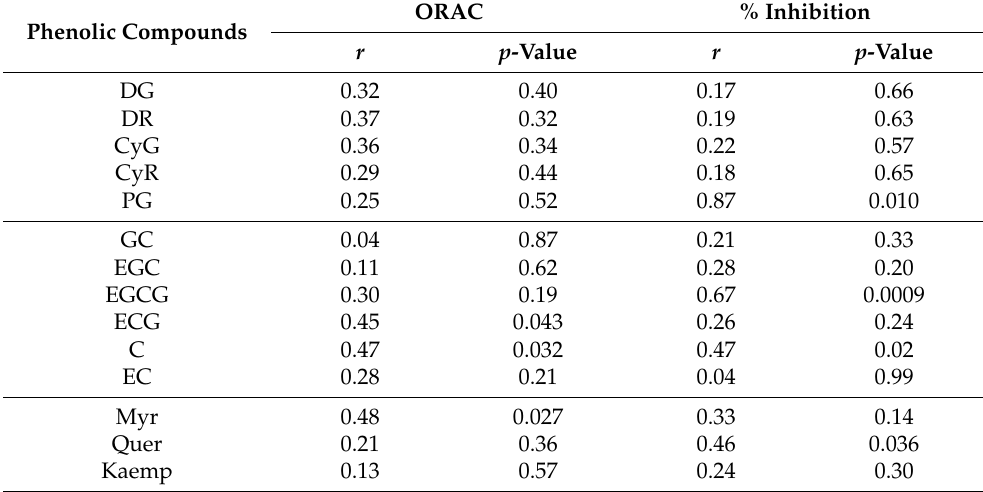
Table 3. Correlations, established for the whole set of juices, between individual phenolic compounds present in the PMA–whole blood assay and either the ORAC values or the % inhibition of superoxide anion